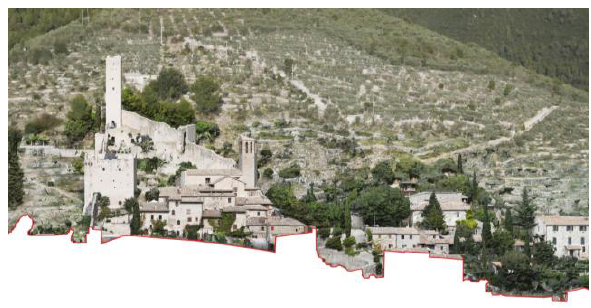
Figure 4. Environment section of the integrated model